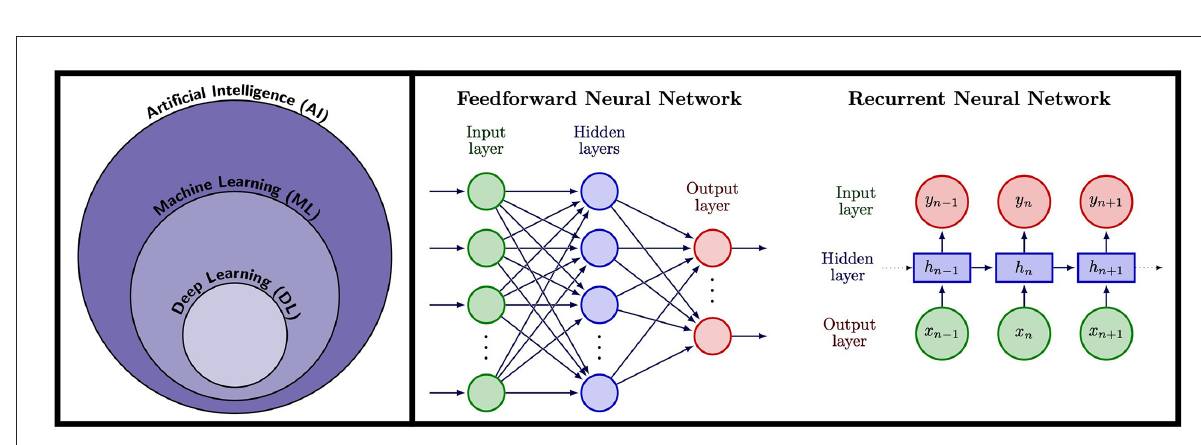
FIGURE2 Left: Artificial Intelligence (AI) encompasses tasks performed by machines and computers that would normally require human intelligence. A subfield of AI is Machine Learning (ML), a technique whereby computer algorithms learn to perform a task from training data rather than requiring explicitly pre-programmed rules, allowing them to provide predictions for unseen examples. Deep Learning (DL) is a subfield of ML that uses artificial Neural Networks (NNs), modeled on neurons in the human brain, trained using data to provide predictions. Right: NN architectures used in cardiac MRF. Feedforward neural networks consist of an input later which could be for example a fingerprint in MRF, followed by a series of hidden layers, followed by a final output later that could output for example tissue parameters. RNNs are ideal for sequence data and take an input timepoint, along with an internal hidden state that encodes information from previous data in the sequence, thus incorporating memory of previous patterns in the sequence.